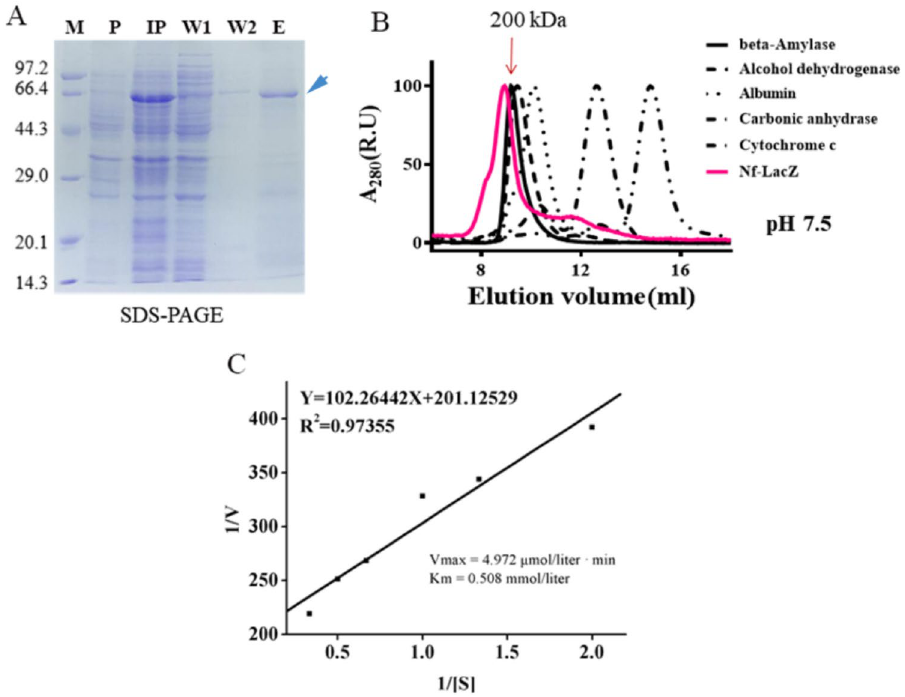
Figure 2. In vitro expression and enzymatic analysis of Nf-LacZ protein. ( A ) In vitro expression of Nf-LacZ by the E. coli BL21/pET28a protein expression system. M marker protein, P total proteins before IPTG induction, IP total proteins after IPTG induction, W1 and W2 washed fractions, E eluted fraction. Blue arrow points to the Nf-LacZ protein. ( B ) The protein polymerization state analyzed by FPLC. Molecular weight markers: beta- amylase, 200 kDa; alcohol dehydrogenase, 150 kDa; albumin, 66 kDa; carbonic anhydrase, 29 kDa; cytochrome c, 12.4 kDa. ( C ) Michaelis kinetic analysis. V max and K m values were calculated. ONPG serves as the substrate. Reaction was conducted at 45 °C and pH